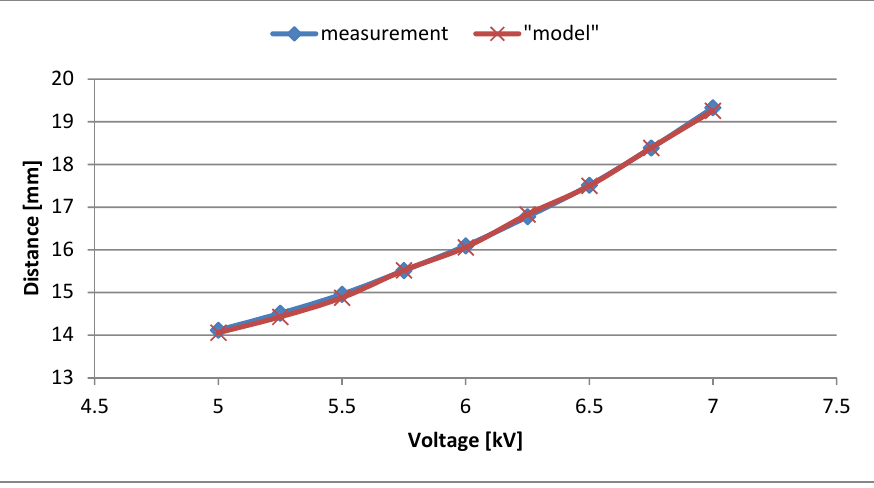
Figure 6. Comparison of membrane distances for static load force 1.23 [N].